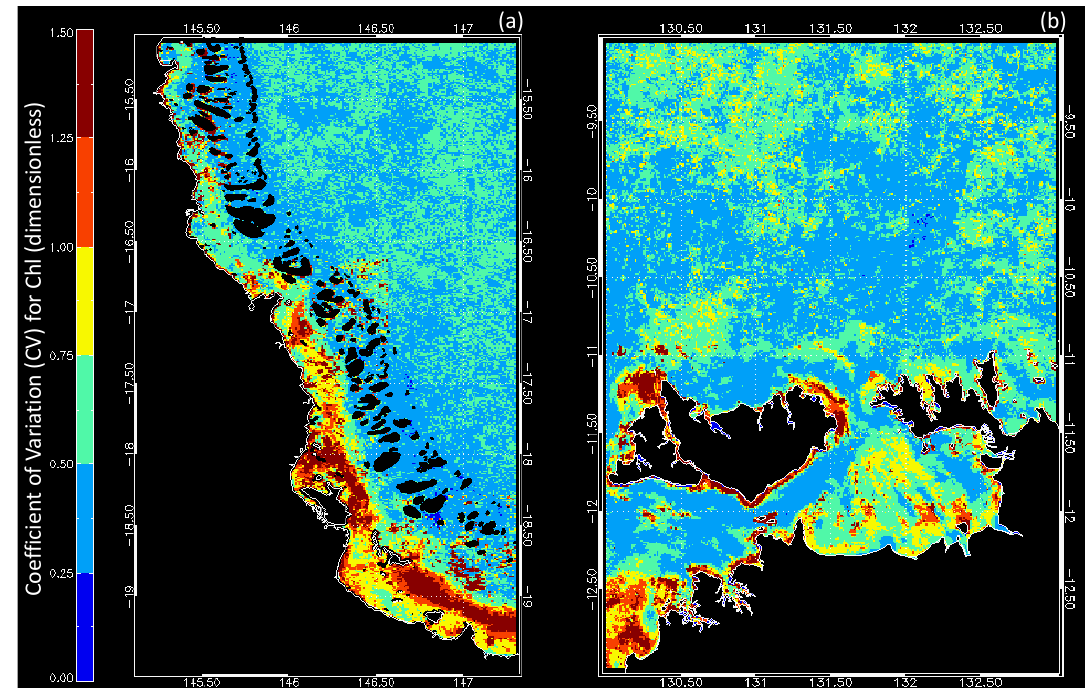
Figure 4. Variability in Chl for ( a ) the GBRW and ( b ) the VDG. The coefficient of variation (CV) was computed from monthly